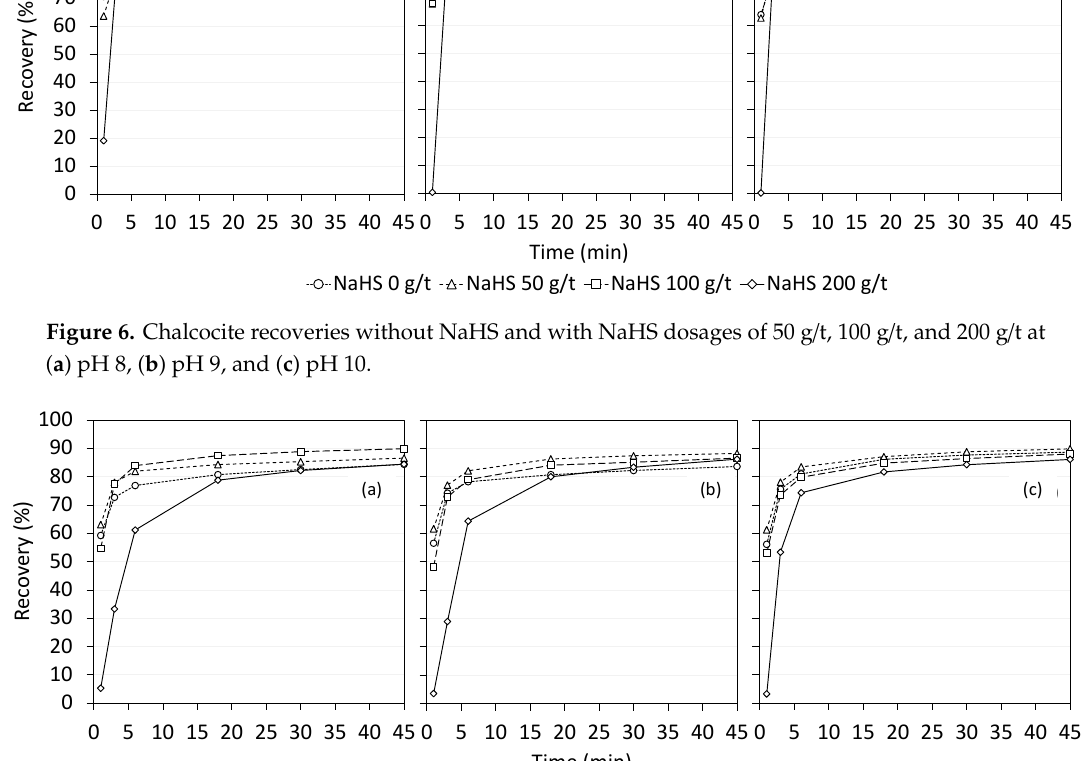
Figure 8. Chalcopyrite recoveries without NaHS and with NaHS dosages of 50 g/t, 100 g/t, and 200 g/t at ( a ) pH 8, ( b ) pH 9, and ( c ) pH 10. Figure 9. Final copper recoveries without NaHS and with NaHS dosages of 50 g/t, 100 g/t, and 200 g/t at pH 8, 9, and 10.